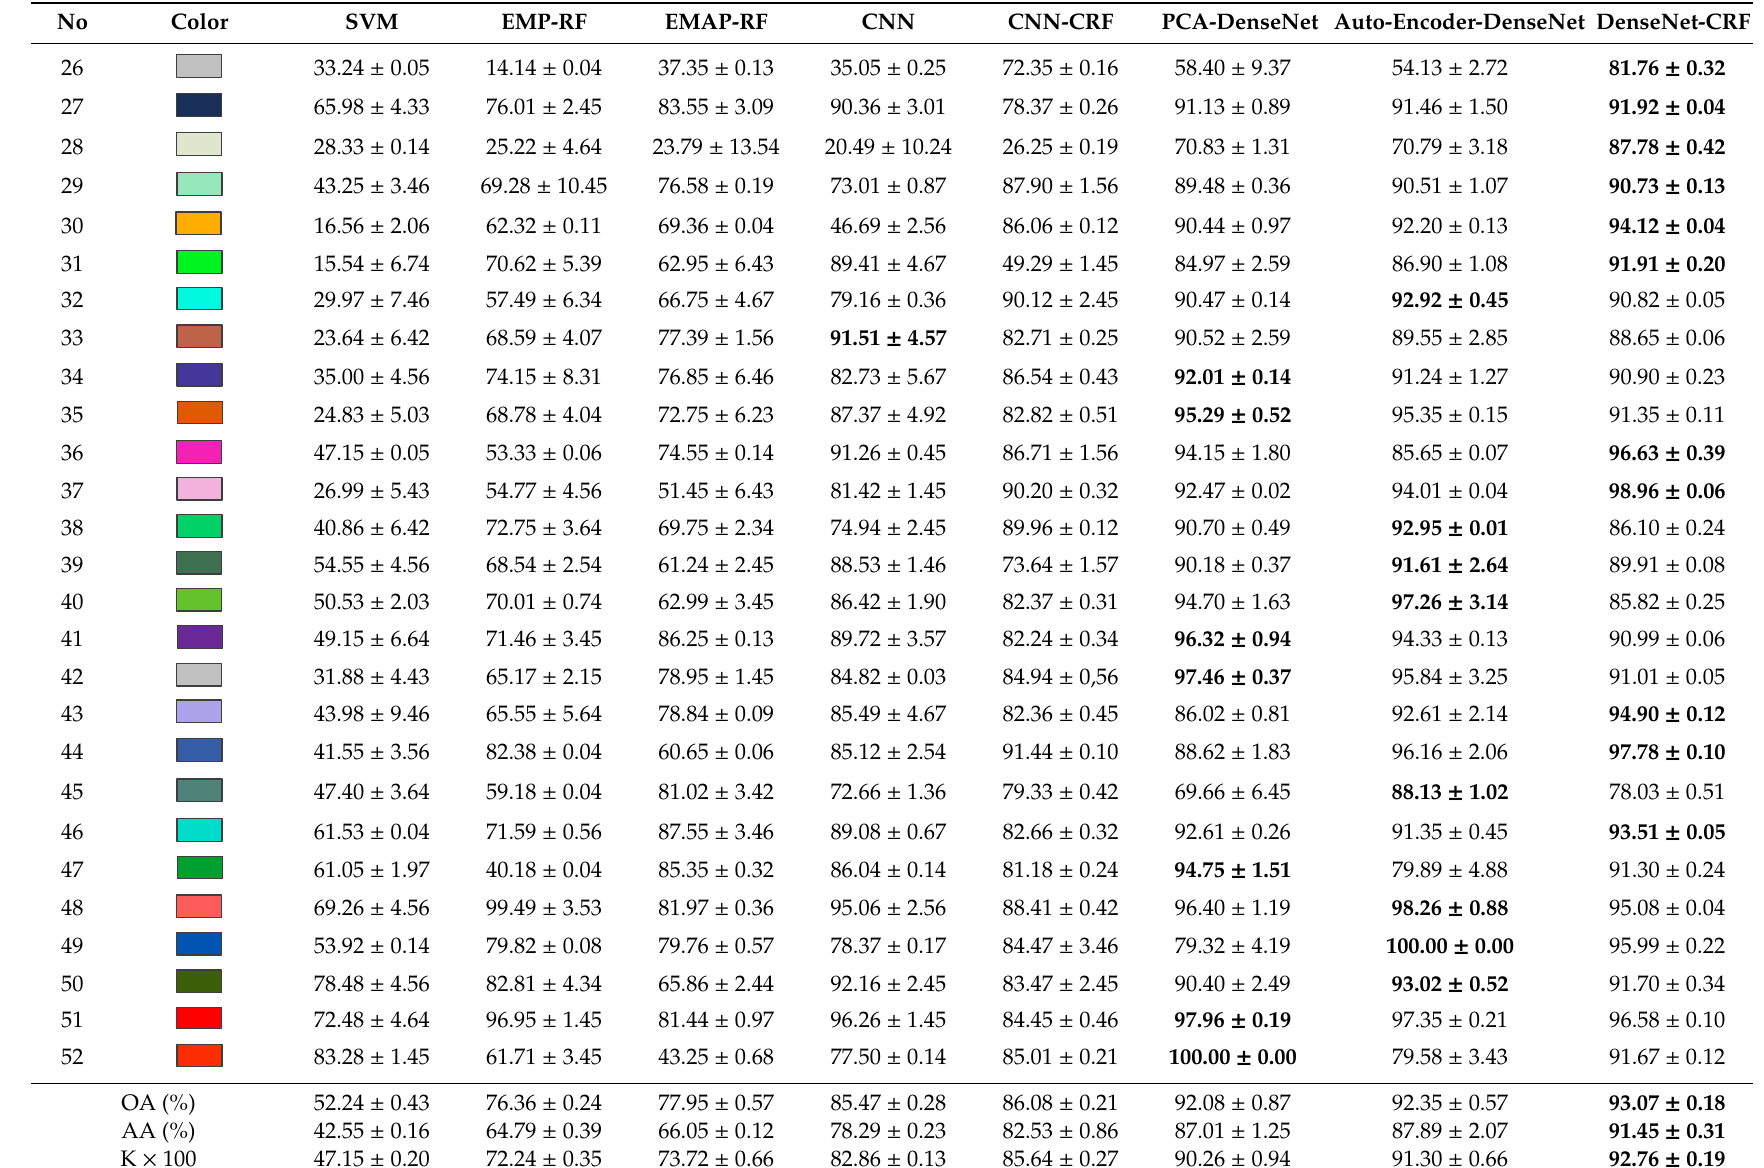
Table 2. The detailed framework of DenseNet.